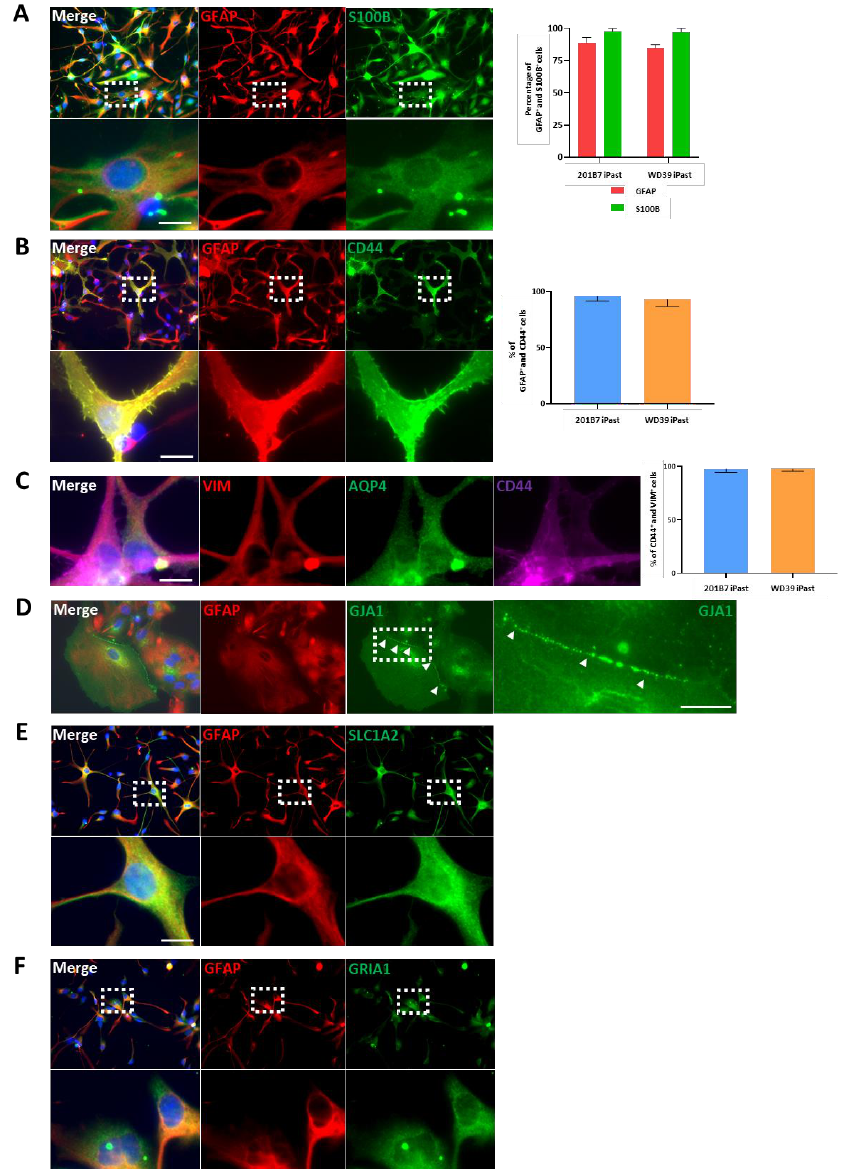
Figure 4. Representative Immunofluorescence Stainings of 201B7 iPasts. ( A ) GFAP (red) and S100B (green) immunostaining of 201B7 iPasts. Lower pictures are high magnification of white dotted-line boxes. Right-hand panel, quantitative analyses of GFAP + and S100B + cells from 5 fields (10,000 µ m 2 ) for 201B7 and WD39 iPasts. ( B ) GFAP (red) and CD44 (green) immunostaining. The lower panel is a high magnification of the white dotted-line boxes. Right-hand panel, percentage of GFAP +/ CD44 + from 5 fields (10,000 µ m 2 ) for 201B7 iPasts and WD39 iPasts. ( C ) Immunostaining for Vimentin (VIM) (red), AQP4 (green) and CD44 (magenta). Right-hand panel, analysis of CD44 +/ VIM + cells from 5 fields (10,000 µ m 2 ) for 201B7 iPasts and WD39 iPasts. ( D ) Immunostaining for GFAP (red) and GJA1 (green). Arrowheads point to GJA1 + gap junction proteins. The picture on the extreme right is a high magnification of the adjacent white dotted-line box. ( E ) Immunostaining for GFAP (red) and SLC1A2 (green). The lower panel represents a high magnification of the corresponding white dotted-line boxes. ( F ) Immunostaining for GFAP (red) and Glutamate Ionotropic Receptor AMPA Type Subunit 1 (GRIA1) (green). Bottom pictures are high magnifications of white dotted-line boxes. Nuclei are stained with Hoechst 33258. n = 3 independent astrocytes induction experiments. Scale bars: 10 µ